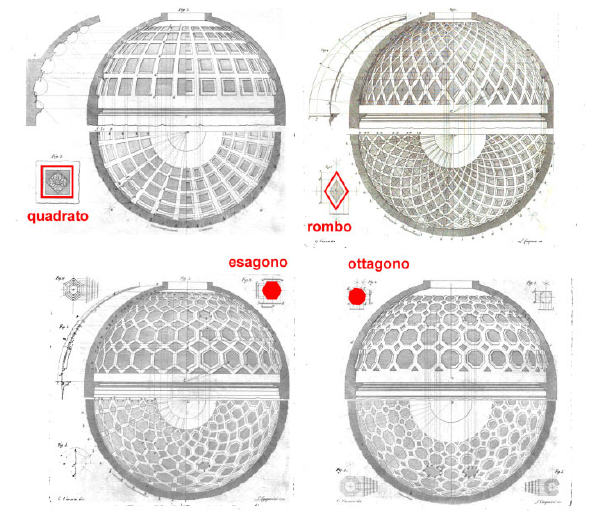
Figure 5. Coffers distribution rules on hemispherical domes